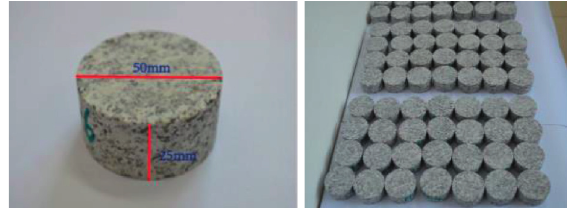
Figure 2: Processed granite